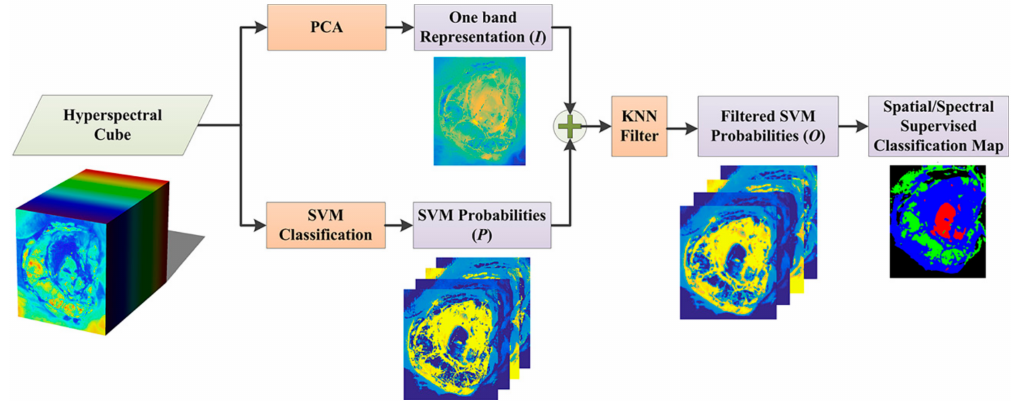
Figure 3. Block diagram of the KNN based spatial-spectral